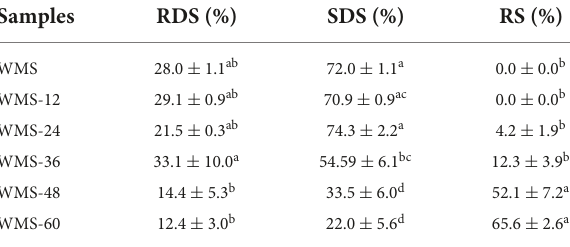
TABLE 1 In vitro digestion profiles of starches from native and fermented starch.